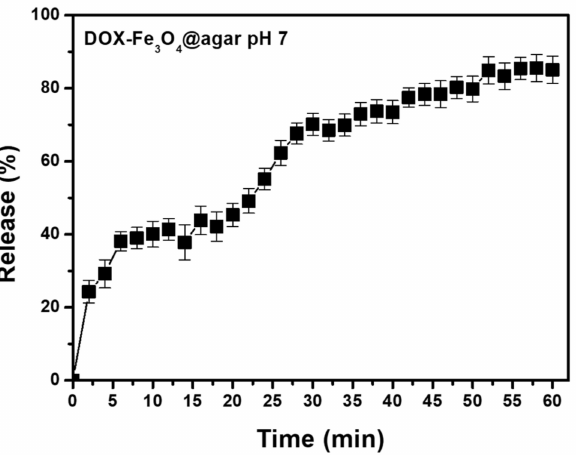
Figure 3. Drug release profiles of DOX-Fe 3 O 4 @agar at pH 7. These results shown are representative of at least three independent